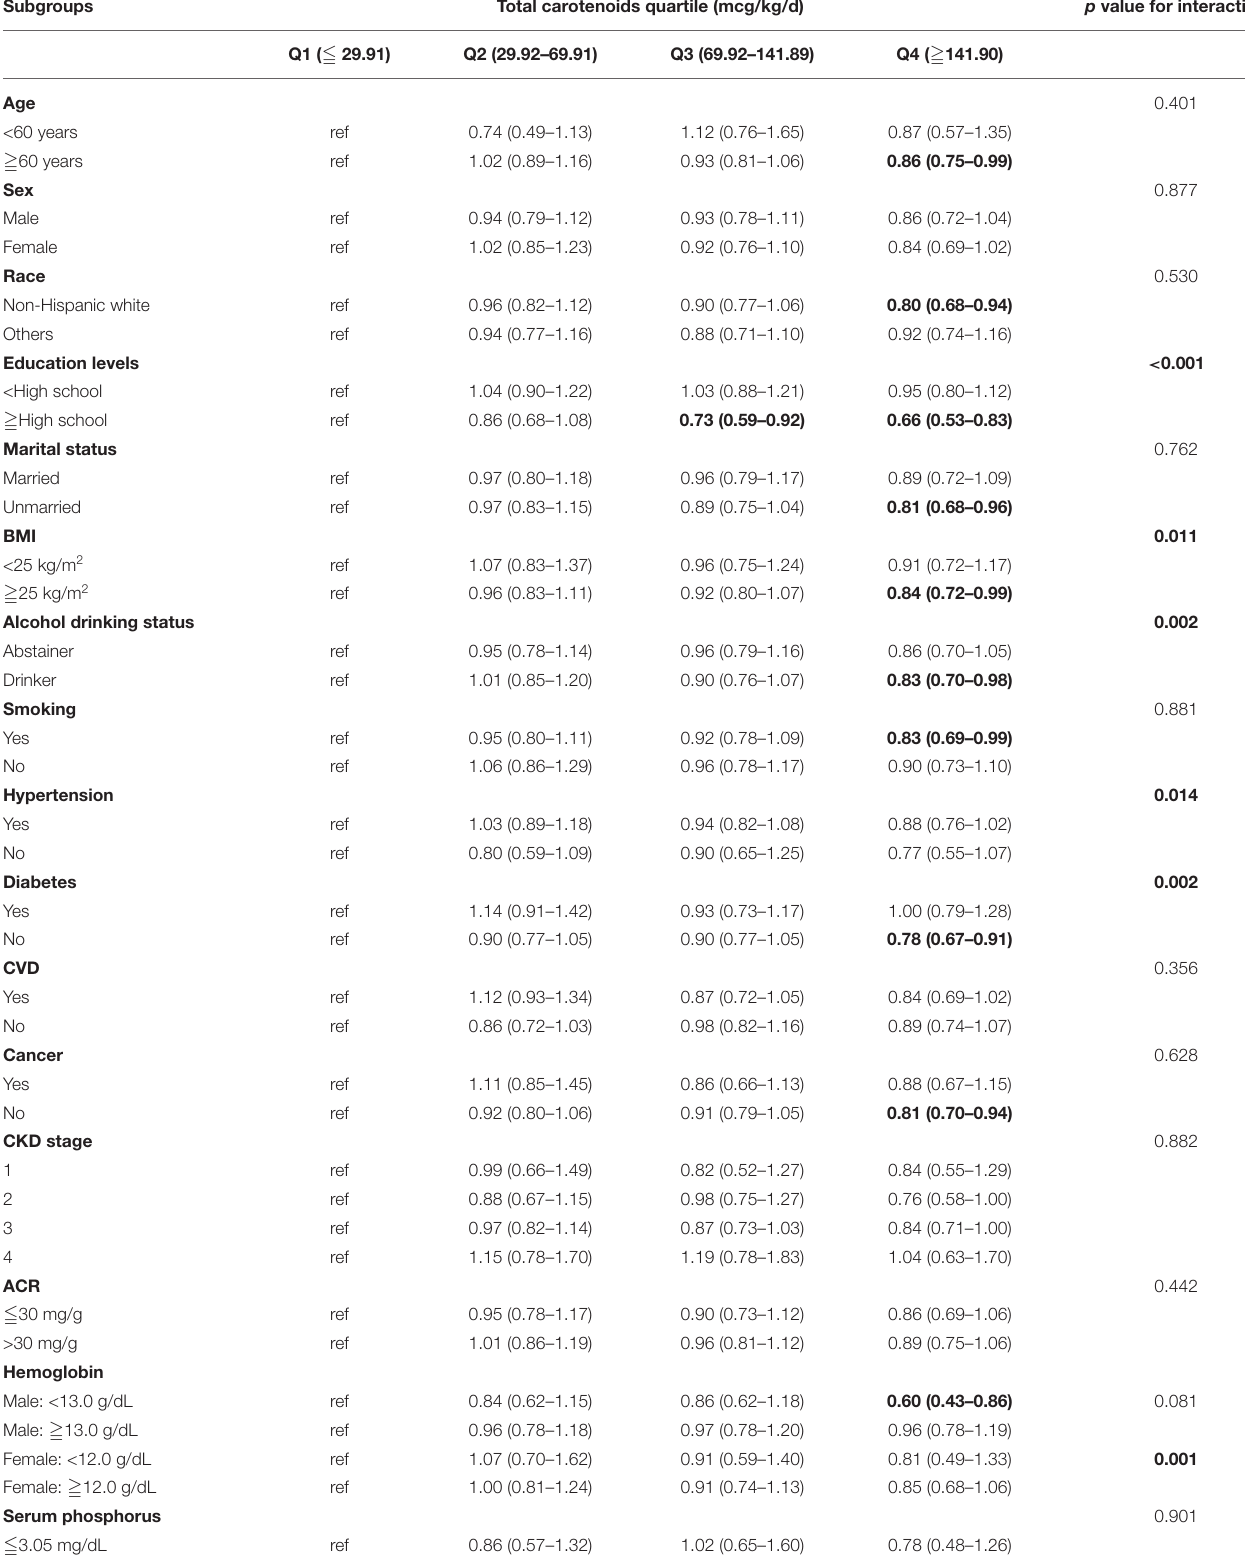
TABLE 4 | Subgroup analyses of the associations between total carotene intakes and mortality.